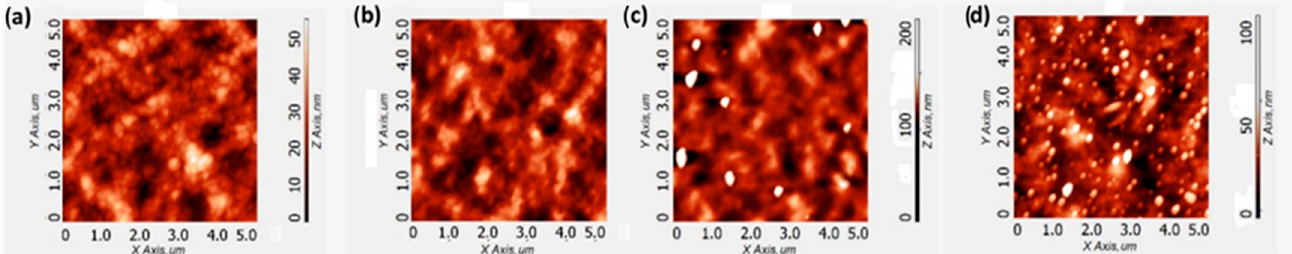
Figure 5. Surface topographic AFM images of ( a ) active layer; ( b ) active layer/ P1 ; ( c ) active layer/ P2 ; and ( d ) active layer/ P3 deposition. RMS values: 8.5 nm, 8.2 nm, 10.9 nm, 10.6 nm for ( a – d ), respectively. The active layer and CPE depositions were carried out in the devices assembly conditions.